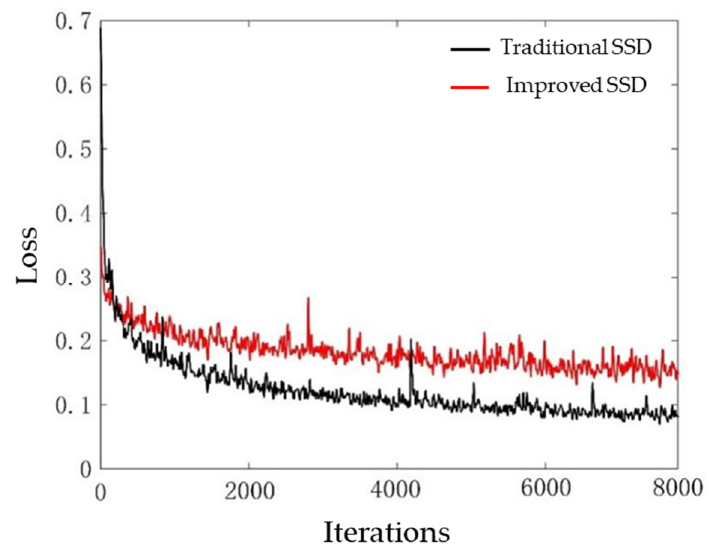
Figure 8. Comparison of loss values of two algorithms.